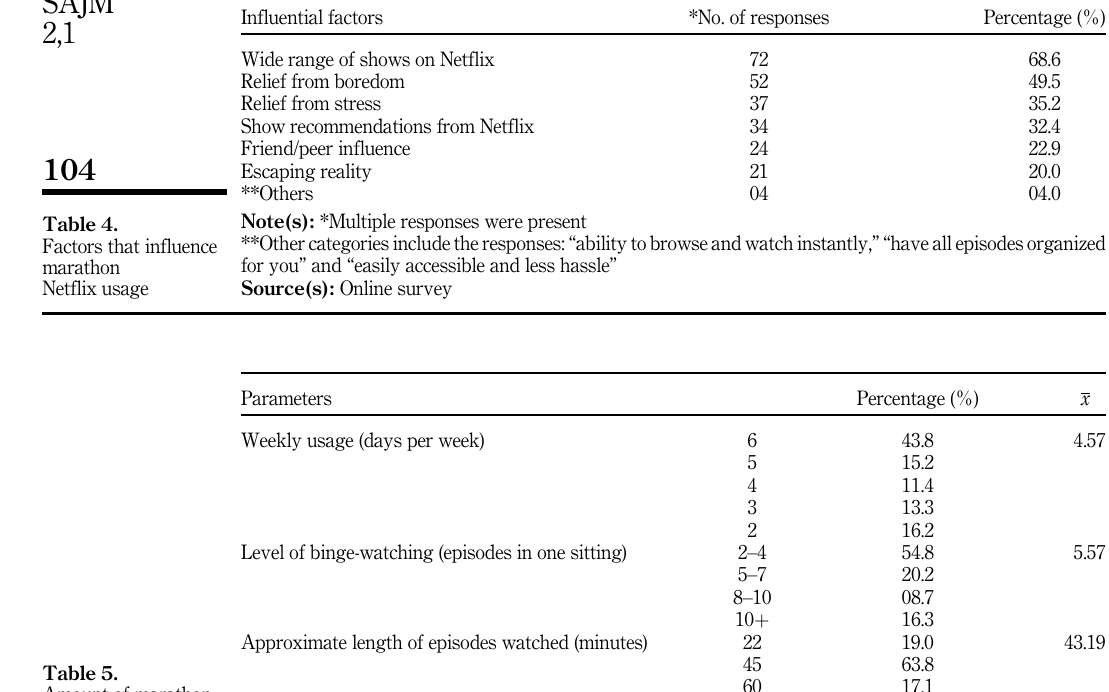
Table 5. Amount of marathon Netflix media